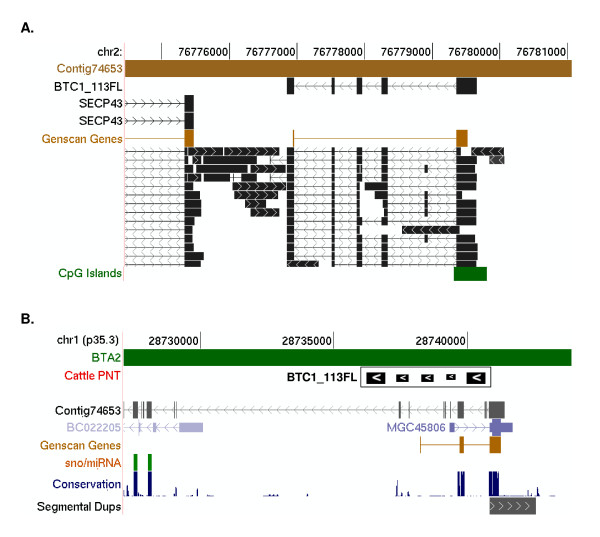
Genomic context of BTC1_113FL. Top panel (A). A modified image from the UCSC cow genome browser (March 2005, Btau_2.0) showing BTC1_113FL aligned to the cow genome (Contig74653; GenBank accession no. AAFC02073929). A track for cattle ESTs ("squish mode") shows high support for alternatively spliced cattle transcripts encoded in this region and the presence of 3' exons of SECP43. Genscan predicts a gene within the alignment of BTC1_113FL but does not predict all of the exons from ESTs. A CpG island is located at the 5' end of the predicted gene. Bottom panel (B). Anchoring of BTC1_113FL represented as a block arrow, to HSA1p35.3 (May 2004, Hg17). BTC1_113FL, was anchored on the basis of its complete alignment to cattle contig74653 and similarity of flanking sequence in the contig to the human genome (shown as vertical lines along the track). This region is syntenic to a segment of BTA2 (shown as a separate track), consistent with RH mapping data [23]. UCSC Genome Browser tracks for known human proteins, Genscan genes, sno/miRNA, conserved sequences, and segmental duplication are unmodified.